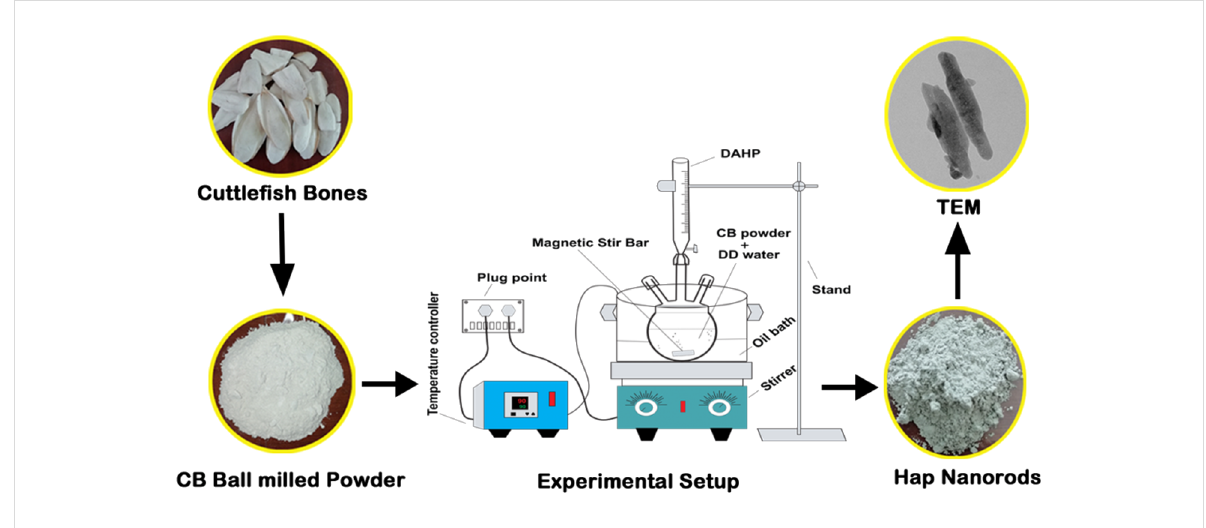
Figure 7: Oil-bath-mediated synthesis of CB-Hap